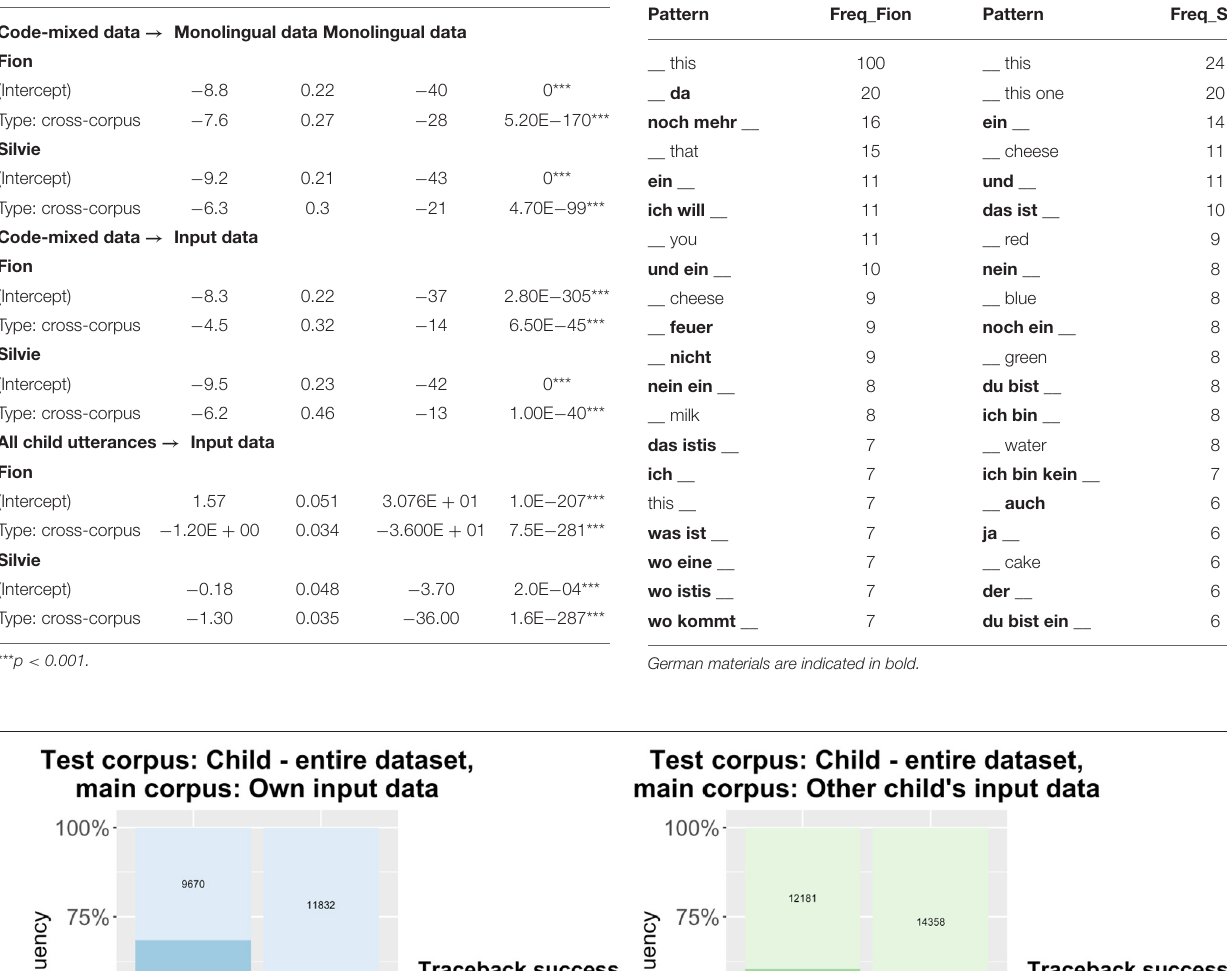
Frontiers in Psychology |